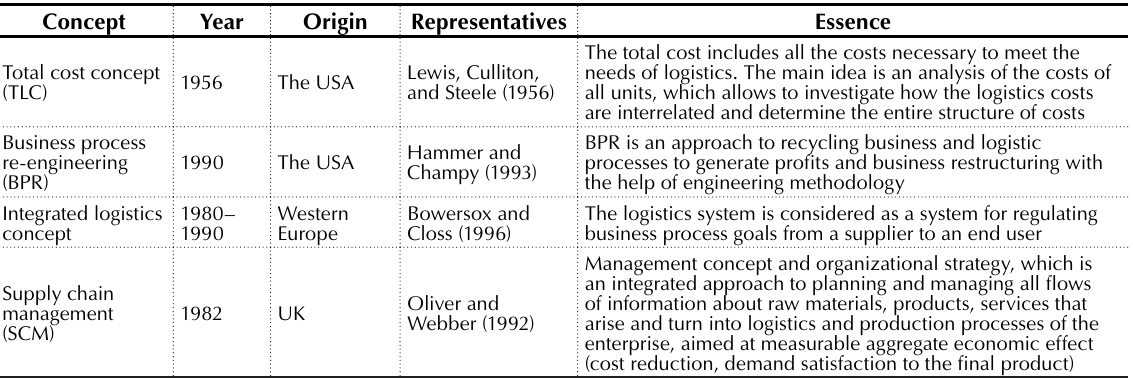
Table 1. Characteristics of fundamental logistic